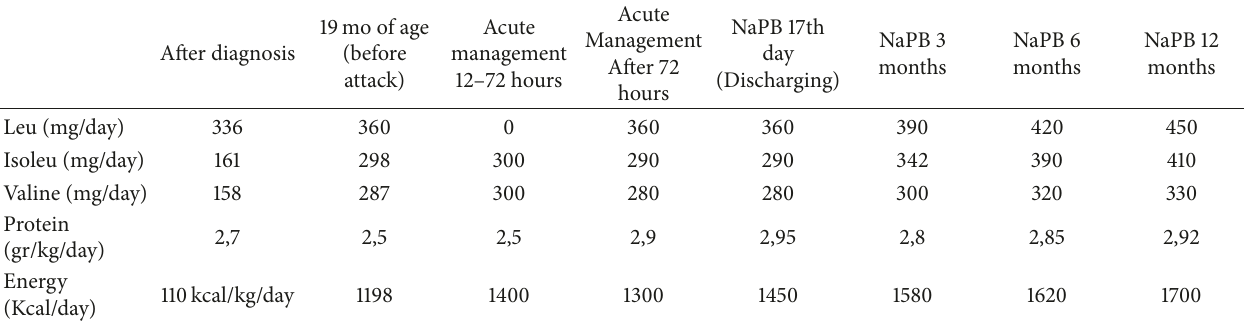
Table 2: Nutritional treatment plan during periods of